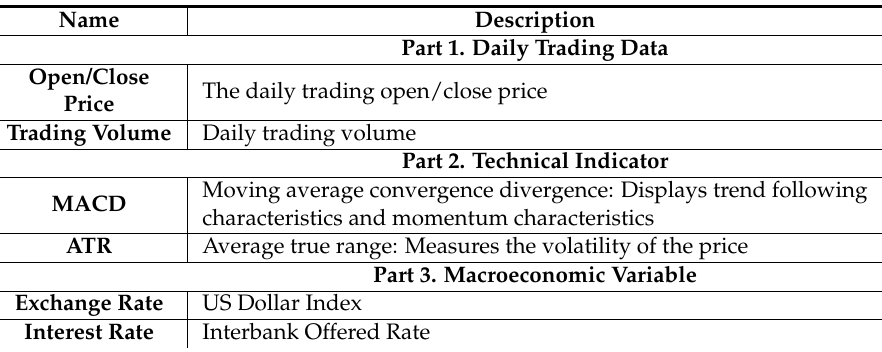
Table 1. Description of the input variables.